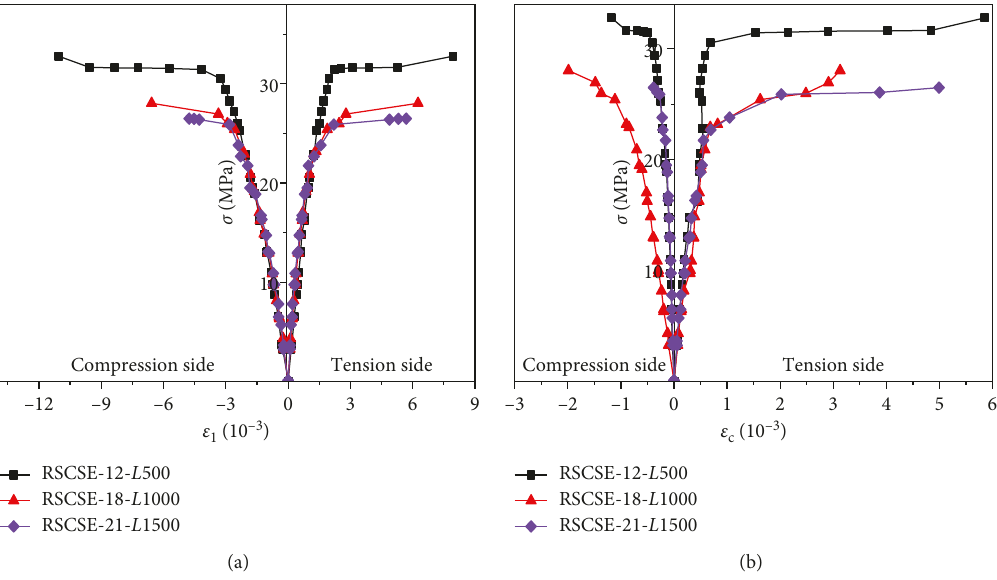
Figure 8: Effect of length-diameter ratio on the stress-strain curve ( e